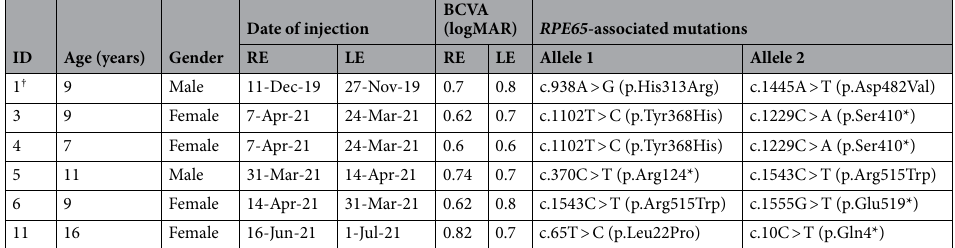
Table 1. Main demographic and genetic features of the study sample at baseline. All nucleotide positions refer to the transcript NM_000329. BCVA best-corrected visual acuity, RE right eye, LE left eye. † Follow-up data related to patient 1 has been already reported in Testa et al.